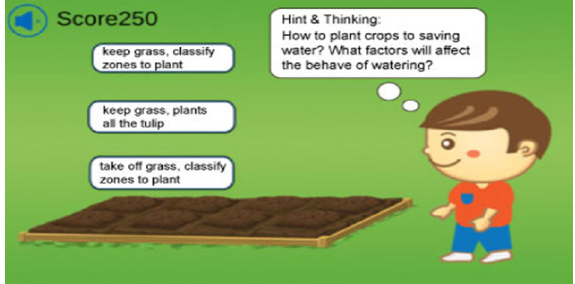
Fig. 2 Hard scaffolding‑ watering flowers in the